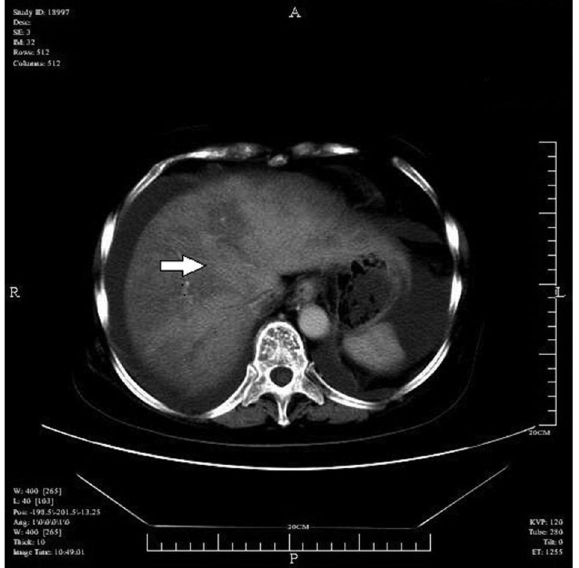
Figure 2. Unenhanced CT image of the inferior vena cava in the liver section of a patient with hepatic veno-occlusive disease. The arrow shows the inferior vena cava with non-homogeneous density.